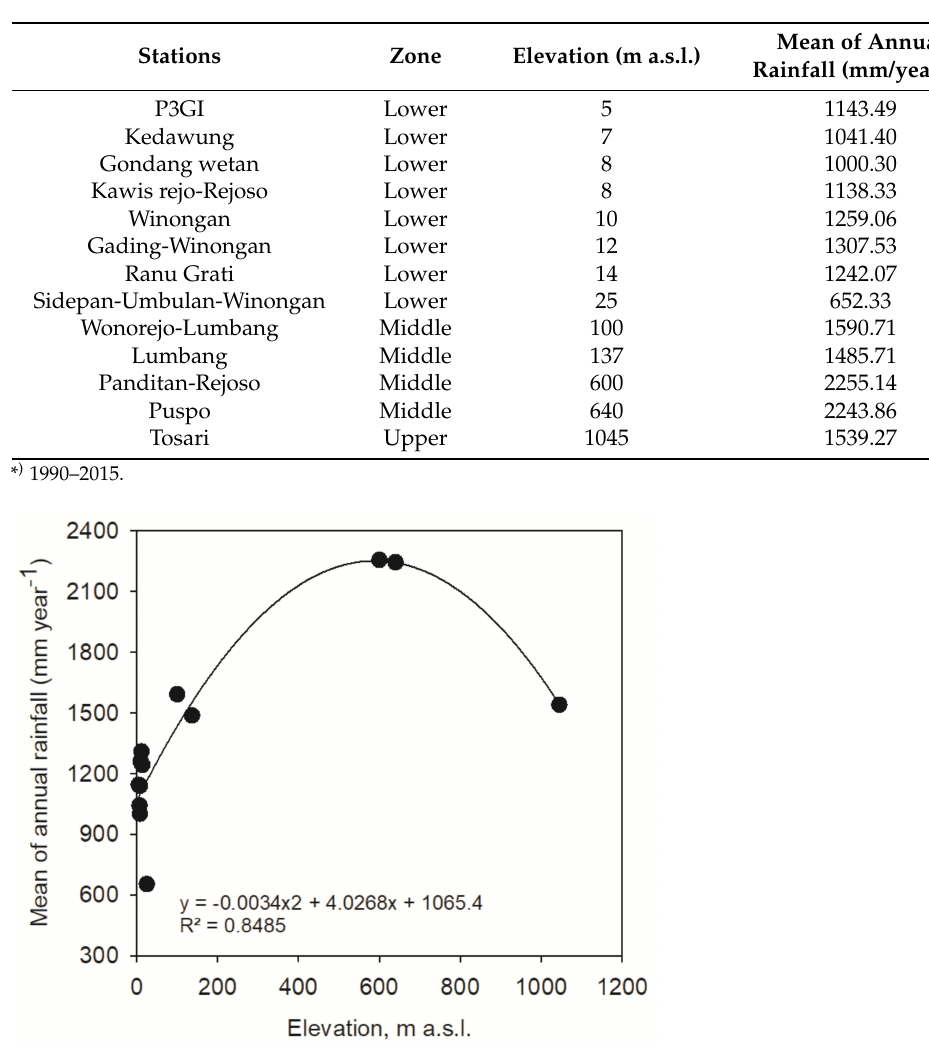
Table A1. Mean of annual rainfall for 13 rainfall stations.